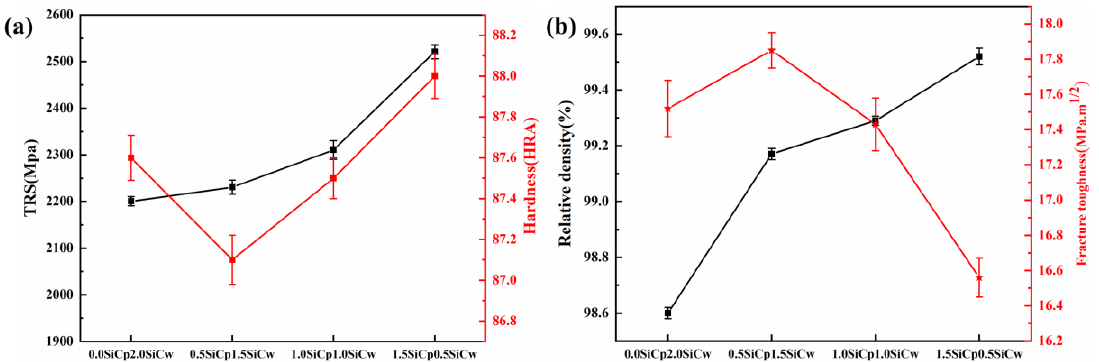
Figure 10. The variation of mechanical properties under different cermets: ( a ) TRS and hardness; ( b ) relative density and fracture toughness.